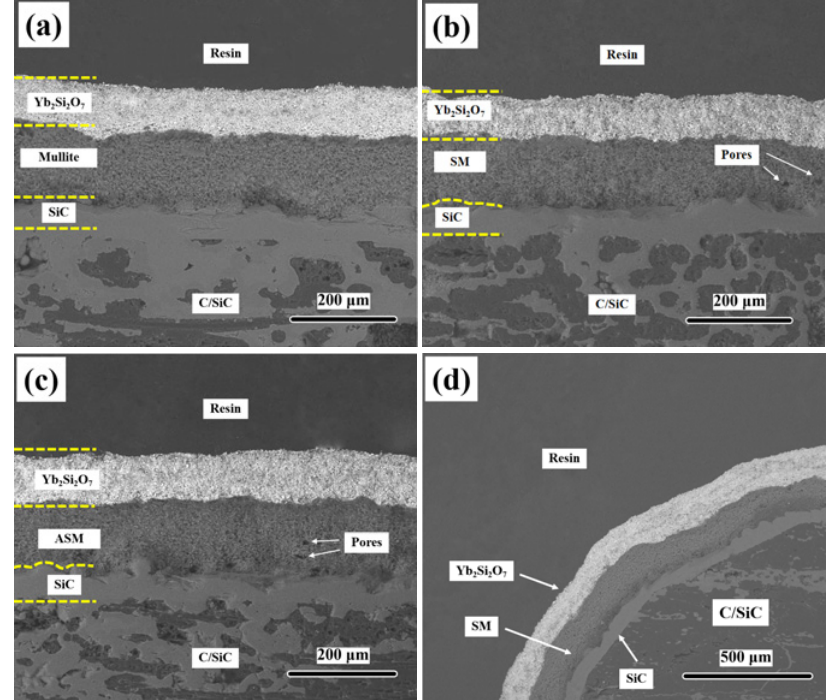
Fig. 5 Cross-section microstructure images of (a) Yb 2 Si 2 O 7 /mullite/SiC, (b) Yb 2 Si 2 O 7 /SM/SiC, and (c) Yb 2 Si 2 O 7 /ASM/SiC coatings-coated C f /SiC samples; and (d) Yb 2 Si 2 O 7 /SM/SiC coating at high